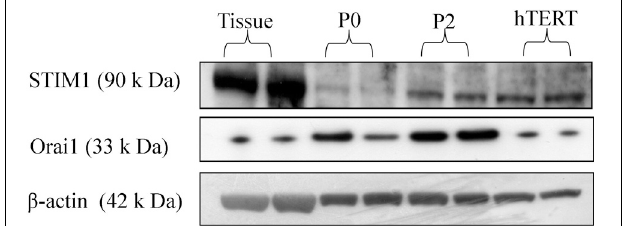
FIGURE 3 | STIM1 and Orai1 protein expression in human myometrium and cultured hUSMCs. Human myometrial tissue and whole cell lysates proteins were separated by SDS-PAGE and probed for STIM1, Orai1, and β -actin (loading control). Representative blots are shown with each band representing tissue/cells from individual patients.